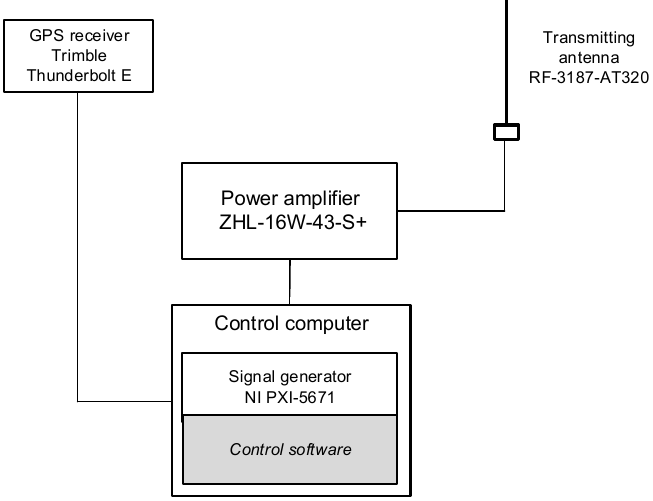
Appl. Sci. 2021 , 11 , 2910 Figure A1. The transmitting part of the testbed for UHF band. Figure A1. The transmitting part of the testbed for UHF band.